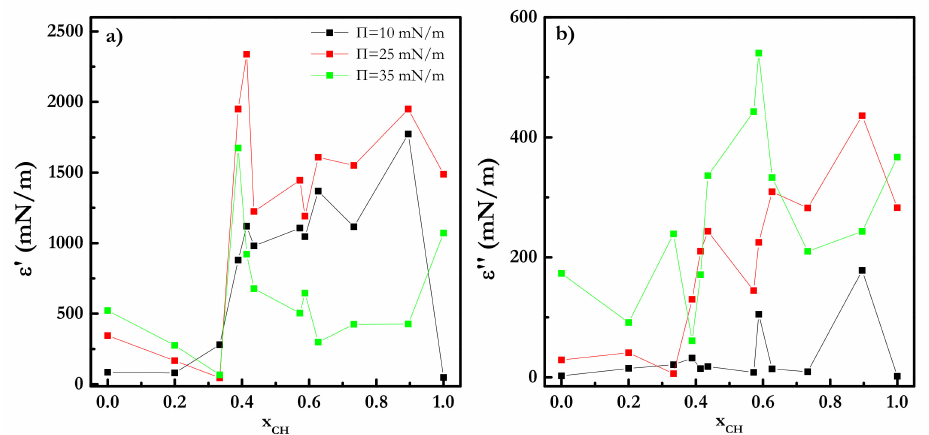
Figure 10. ( a ) Dependences of the dilational elasticity on x CH for binary mixtures of CH and CS spread at the water/vapor interface at different surface pressures at 24 ◦ C. ( b ) Dependences of the dilational viscous modulus on x CH for binary mixtures of CH and CS spread at the water/vapor interface at different surface pressures at 24 ◦ C. The lines are guides for the eyes, and the color legend is the same for the both